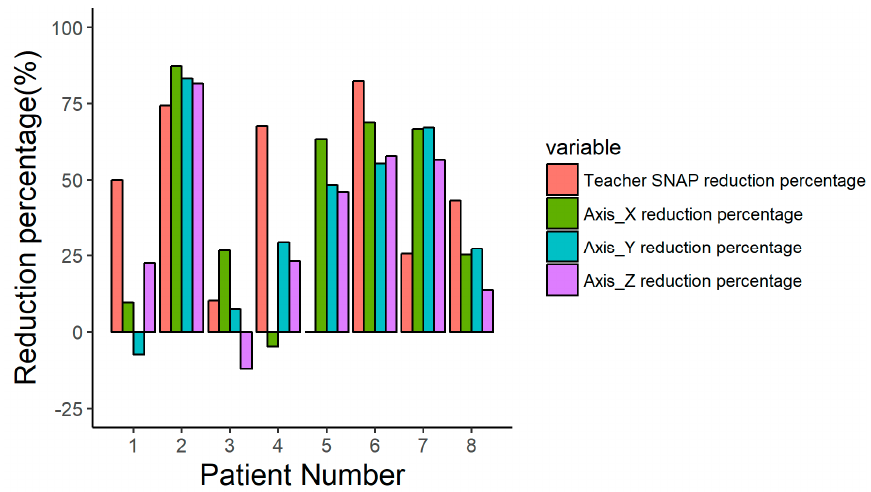
Figure 2. Correlation between decreased Swanson, Nolan, and Pelham (SNAP) questionnaire scores and reduction in variance values. Some patients with ADHD exhibited discrepancy between decreased SNAP scores and reduced accelerometer variance values of along the three axes.